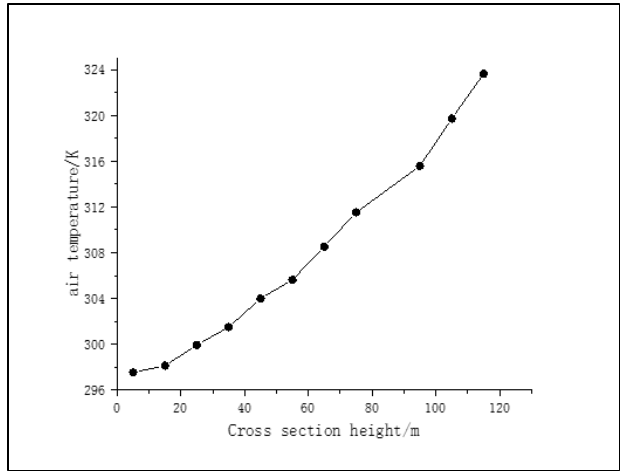
Figure 6. Average air temperature at different cross section heights.